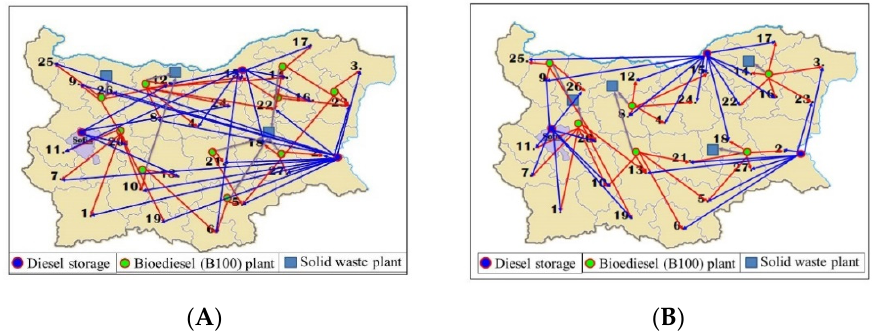
Figure 2. ( A ) Minimum total GHG emissions. ( B ) Minimum total annual costs. Optimal structure of IBDSC and logistics in terms of delivery to customers of biodiesel and petroleum diesel, as well as solid waste logistics to plants for their use for 2020.